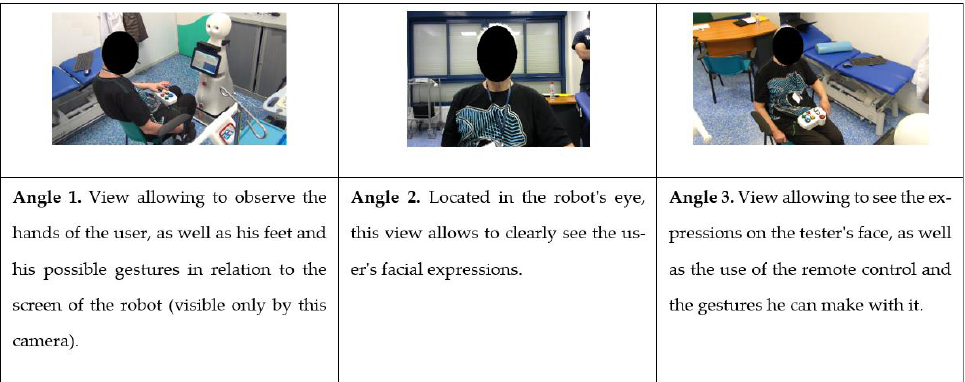
Figure 5. Different camera angles to capture and analyze the activity .